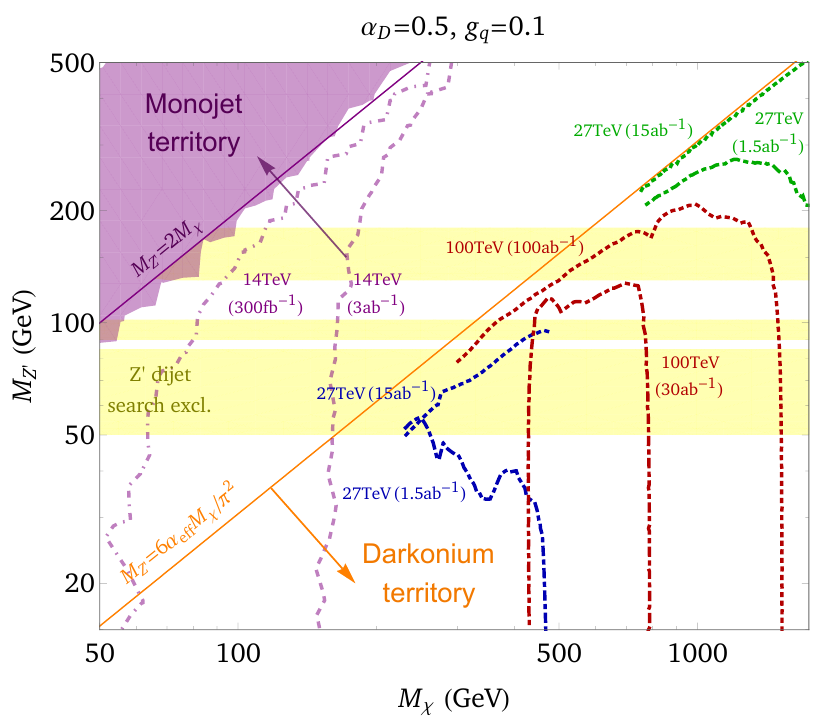
Figure 1 . Colorful curves show the future high-energy pp collider constraints on the model where a fermionic dark matter (cid:31) interacts with SM quarks via a Z 0 boson. For the couplings de(cid:12)ned in eq. (2.1), we set g q = 0 : 1, (cid:11) (cid:31) = 0 : 5 and g 0 = M Z 0 =M (cid:31) . The regions to the left of the cyan (cid:31) curves (monojet search) and below the blue, red, green curves (darkonium resonance search) could be covered. The horizontal yellow bands are excluded by the existing dijet search for Z 0 . In the future, this search will cover all the region above M Z 0 > 50 GeV but below the orange